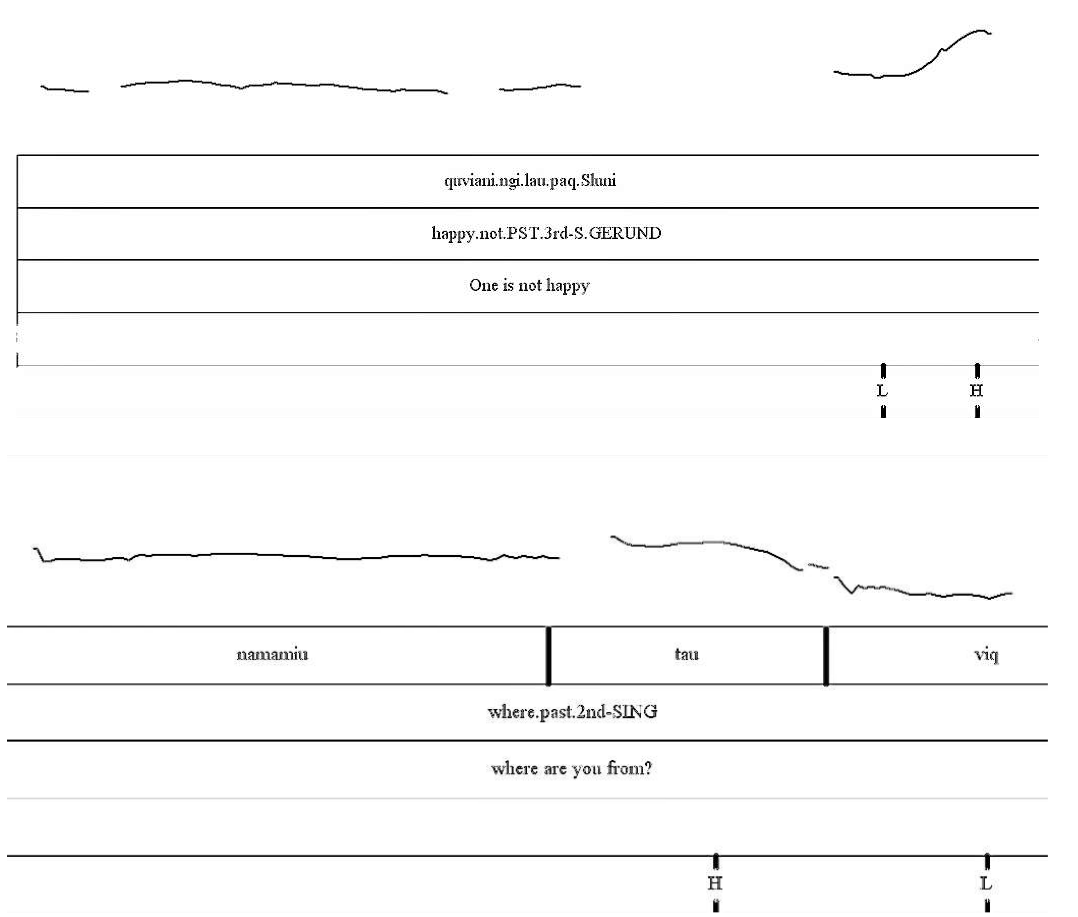
Figure 1. Realization of intonational contours in Inuktitut. Top: Rising contour to hold a turn; female speaker from Baker Lake (Shokeir 2009, p. 21). Bottom: Falling contour to indicate the end of a turn; female speaker from Iqaluit (Shokeir 2009, p. 24).